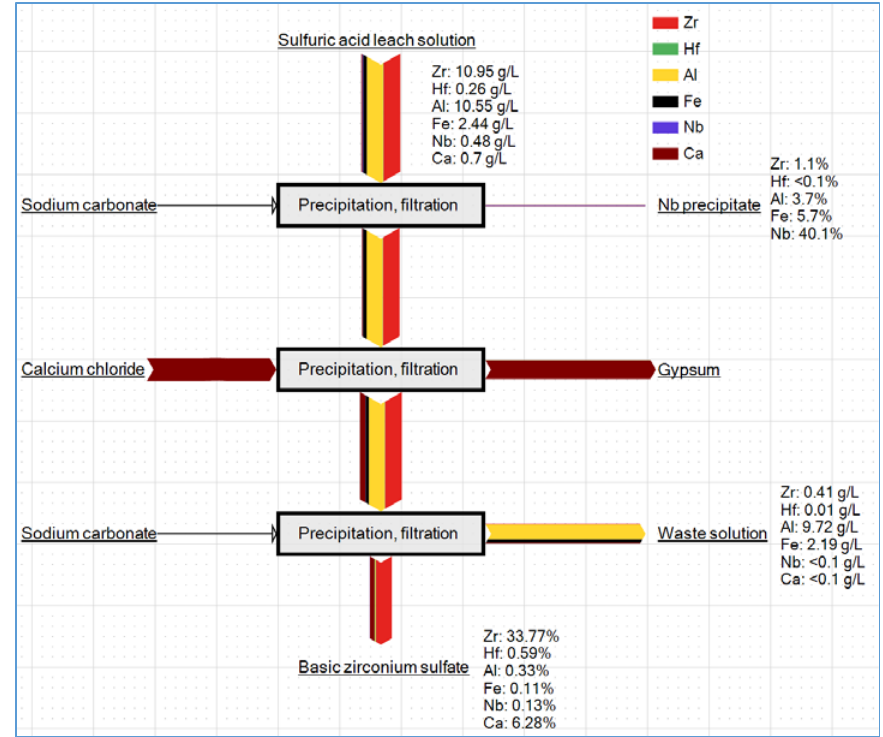
Figure 11. IR spectra of the basic zirconium sulfate precipitate and pure zirconium sulfate salts.